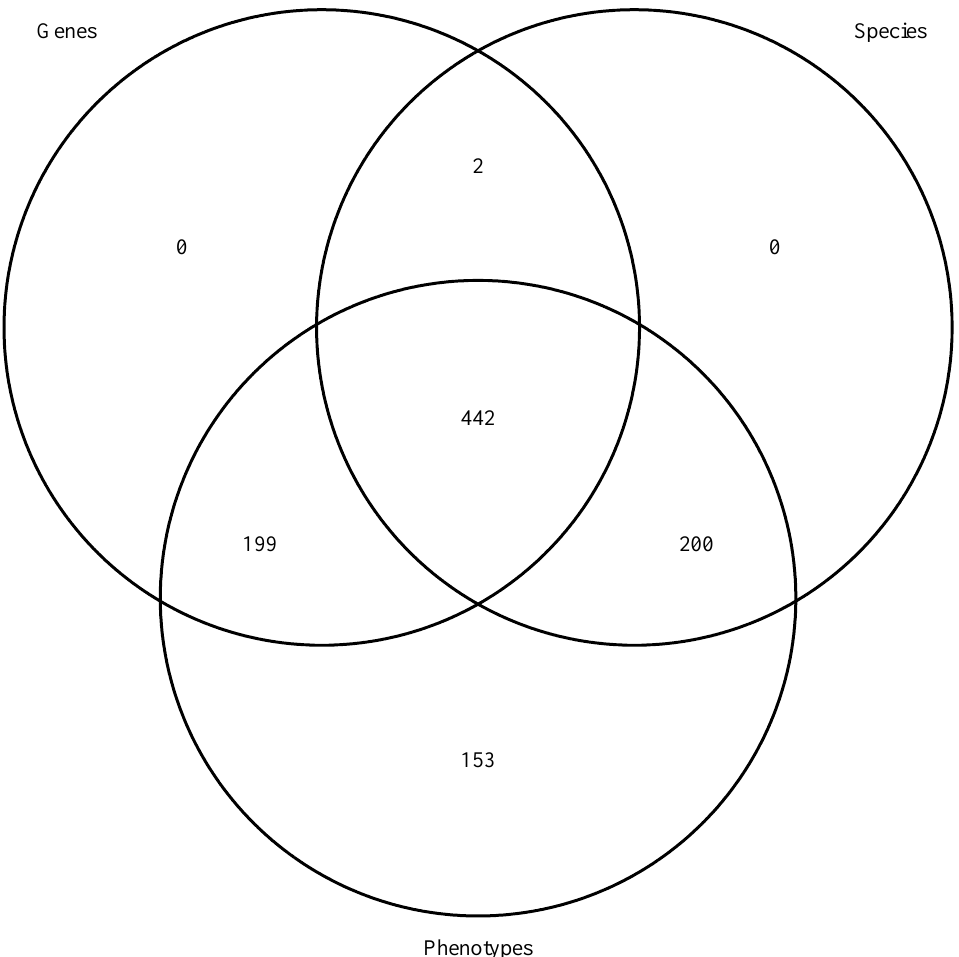
Figure 2. A Venn diagram showing the results of the consensus analysis (module 5) conducted on a subset of abstracts related to drought tolerance in plants. Abbreviations: G = genes; Ta = taxonomy; P = phenotypes.